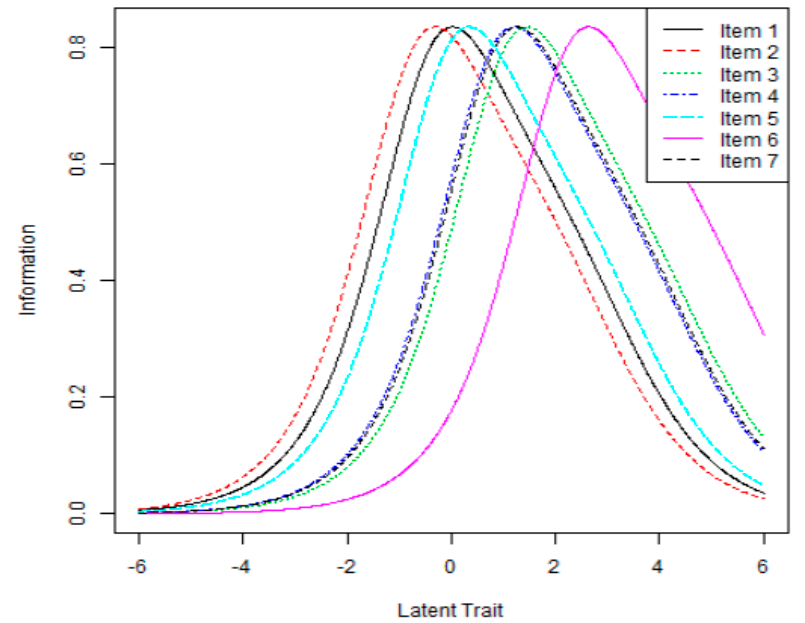
Figure 2. Item information curves.